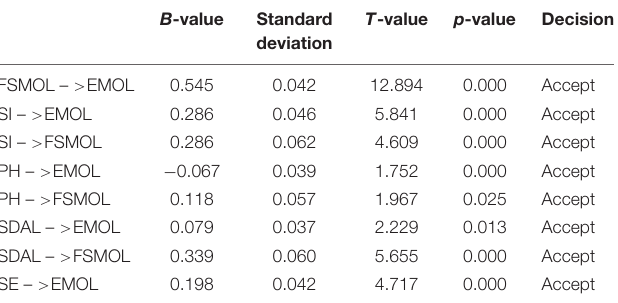
TABLE 4 | Direct effects of the variables.